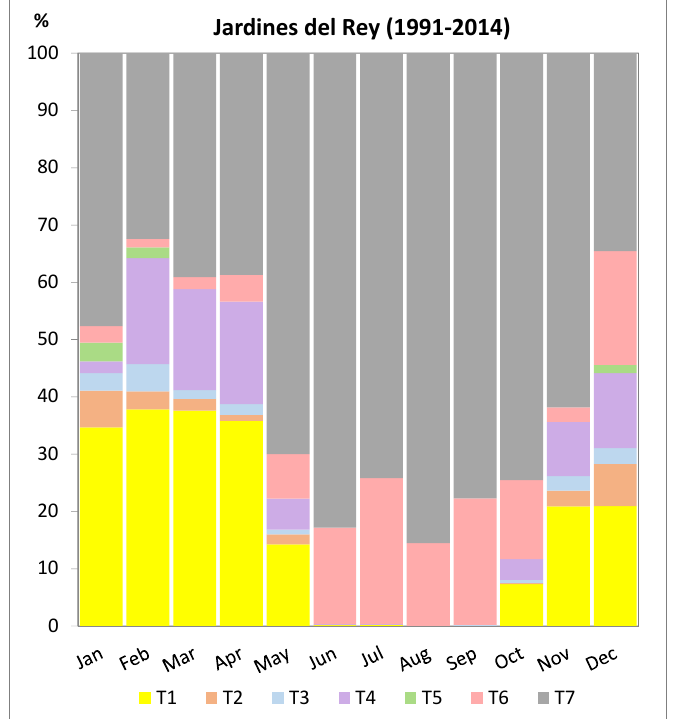
Figure 1. Annual distribution of weather types in Jardines del Rey (1991–2014).